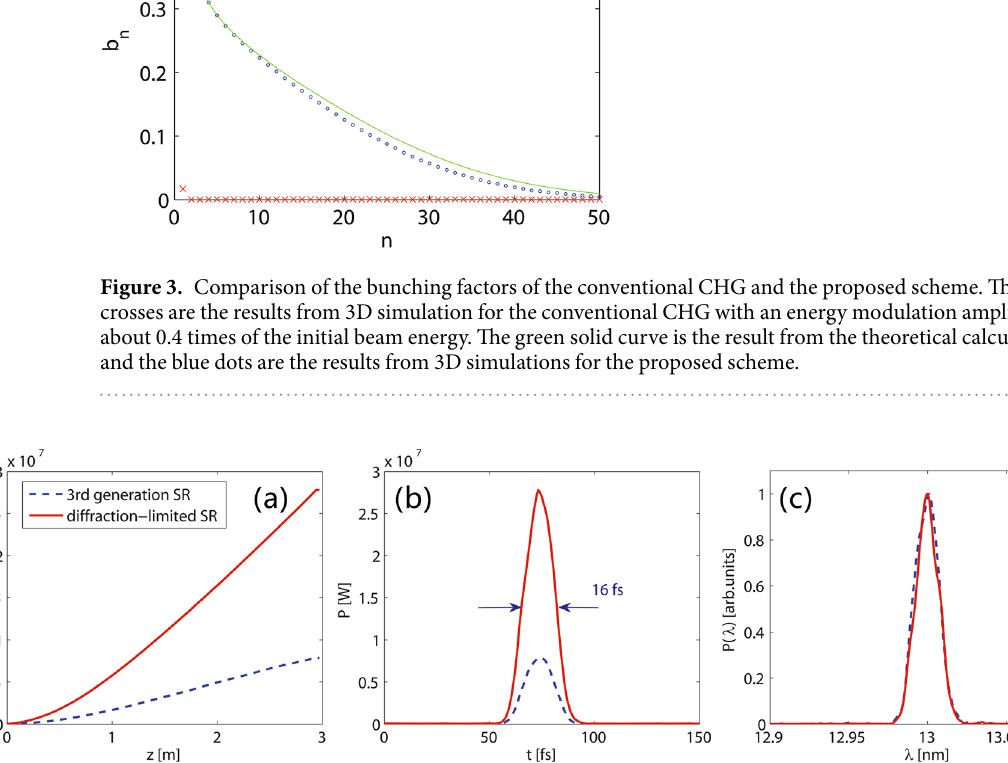
Figure 4. FEL performance of the proposed scheme. Simulations have been performed with parameters of a 3 rd generation SR (blue line) and a diffraction limited SR (red line): ( a ) peak power growth as a function of the radiator distance; ( b ) output radiation pulses and ( c ) output spectra at the exit of the